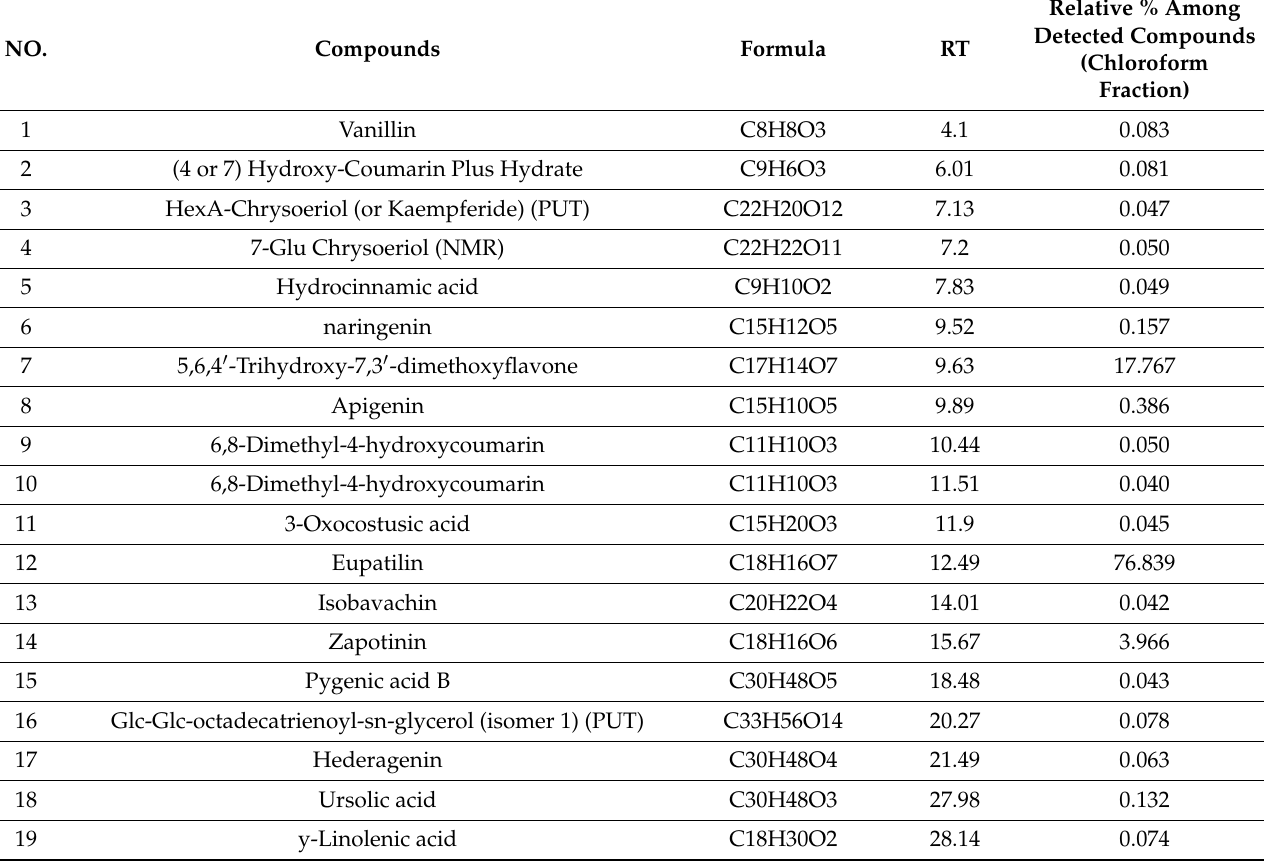
Table 2. LC-MS analysis of X. spinosum chloroform fraction.